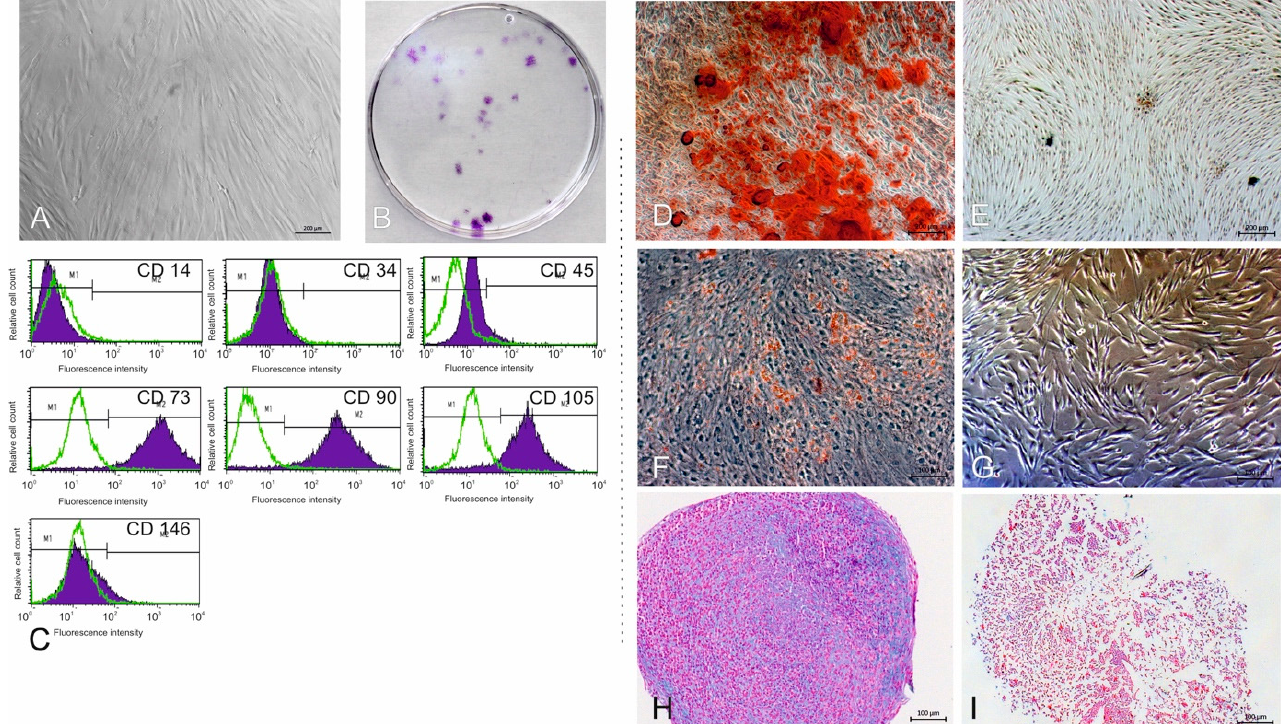
Figure 1. Phase contrast inverted microscopic picture of gingival cells growing out from a gingival connective tissue specimen ( A ). G-MSCs’ colony-forming units (CFUs) ( B ). G-MSCs surface markers’ expression flowcytometrically ( C ). Osteogenic induction of G-MSCs (Alizarin-Red stained; ( D )) and respective controls ( E ) Adipogenic induction of G-MSCs (Oil-Red-O stained; ( F )) and respective controls ( G ). Chondrogenic induction of G-MSCs (Alcian Blue/acid-fast-red staining; ( H )) and respective controls ( I ).